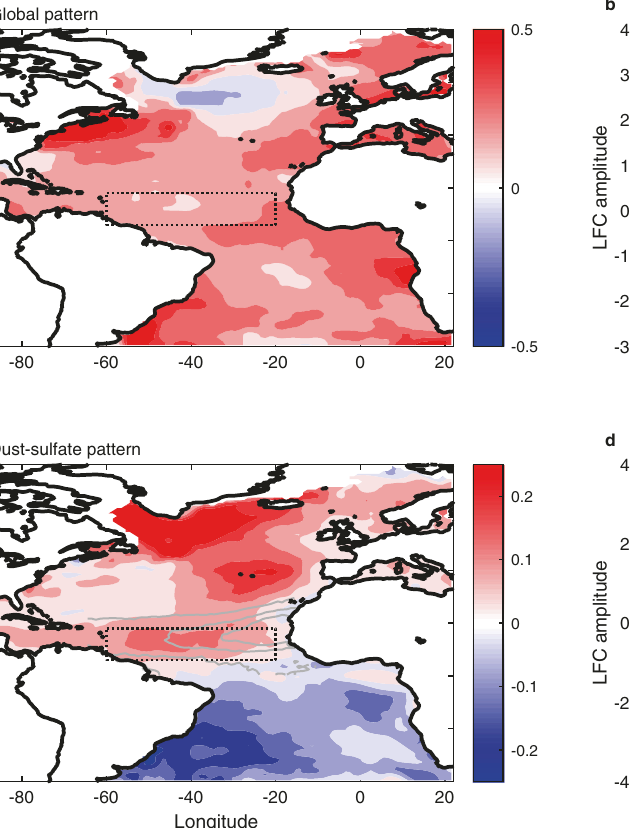
for τ =[0.150.30.45](graycontours),andthemaindevelopmentregionisidenti fi ed (dotted black box). Associated components for the global mode ( b ) and the dust- sulfate mode ( d ), including variability at all frequencies (gray) and only at low frequencies